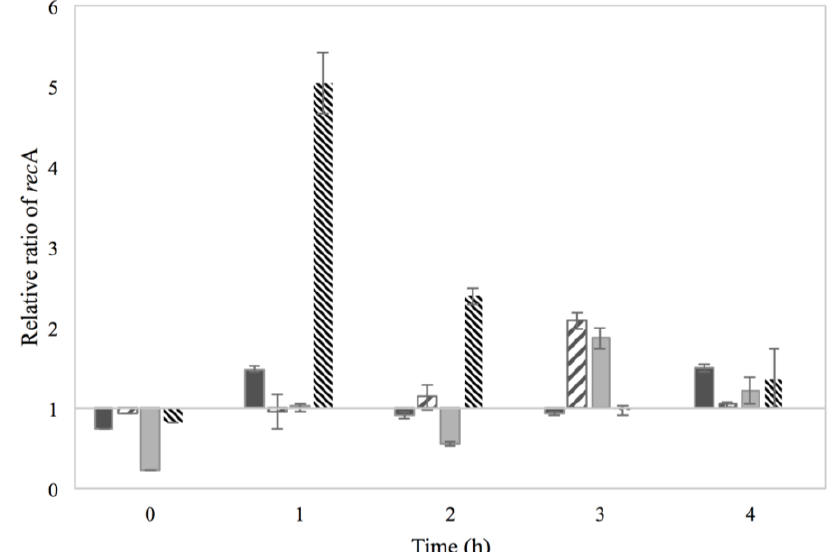
Figure 4. Relative rec A mRNA transcript levels of Sa17 steady state cells under exposure in batch conditions to 2% NaCl (■), 0.15% sorbic acid ( ), 2% NaCl + 0.15% sorbic acid (■) and the control of MMC ( ), obtained from two independent experiments. The Y axis represents the rec A relative ratio levels as calculated from Cq values and the X axis the time in h. Values below/above 1 in relative ratio demonstrate down- or up-regulation of rec A in relation to the control condition of BHI with no additives (value of